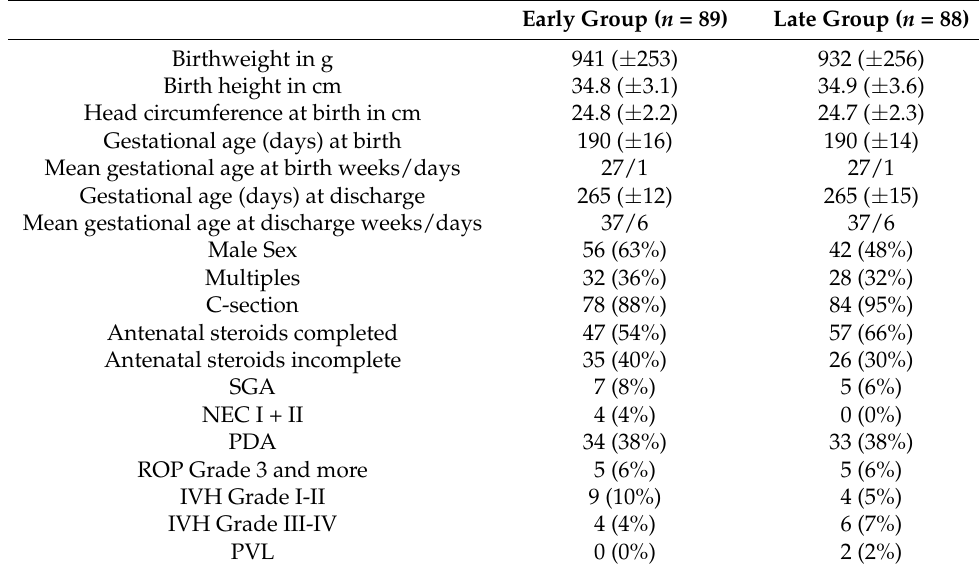
Table 1. Baseline characteristics of the intention-to-treat